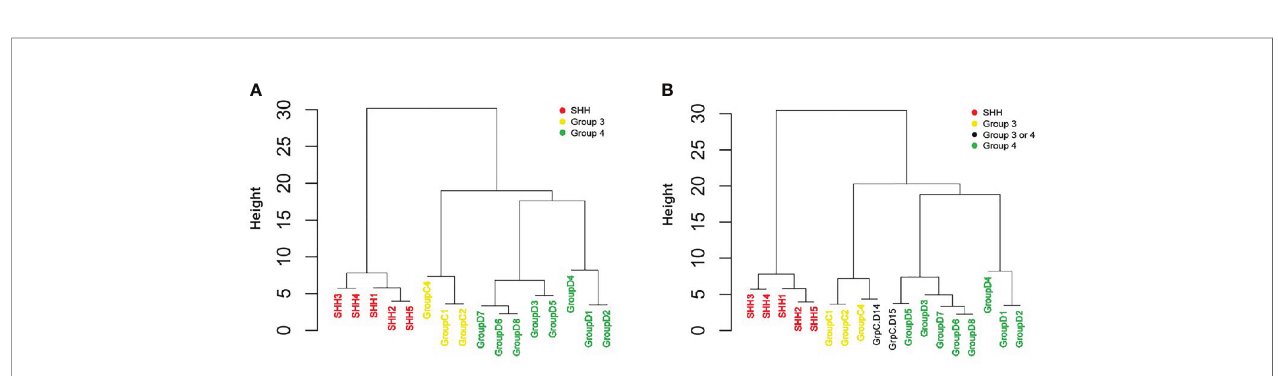
FIGURE 4 | qPCR-based classi fi cation of an independent cohort, using reduced six-gene setout of the 22-gene NanoString set ( IMPG2 , NPR3 , KHDRBS2 , RBM24 , WIF1 , and EMX2 ). An unsupervised hierarchical clustering of gene expression levels was generated by using qPCR (dCt) values. (A) A cohort of 16 patients who were classi fi ed by NanoString as having either SHH, Group 3, or Group 4 MBs (n = 5, 3, and 8, respectively; see Figure 3 and Supplementary Table S6 ). (B) The same cohort, but with the addition of two patients who were classi fi ed as having a non-WNT/SHH MB. The Height (y axis) is a measure of closeness of either individual data points or